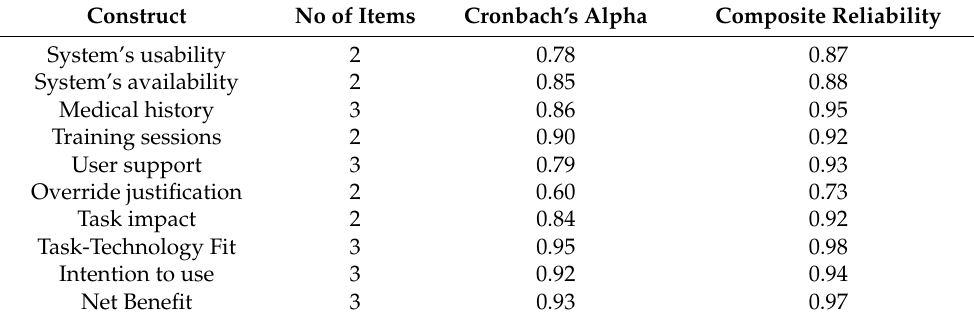
Table 2. Reliability results.